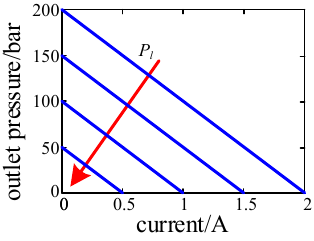
Figure 7. The PFV characteristics curve.